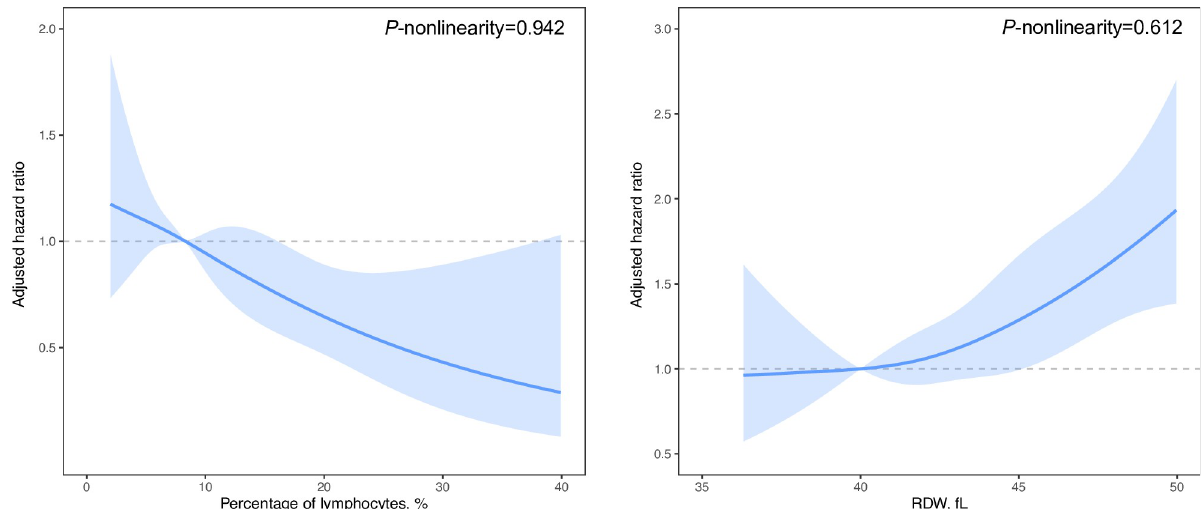
Fig 2. Dose-response curves for lymphocyte percentage and RDW level with risk of AAD in-hospital mortality. Hazard ratios (blue lines) and 95% confidence intervals (light blue shade) were adjusted for age, sex, smoking history, hypertension history, diabetes history, aortic valve replacement history, anatomical classification, etiology, aorta diameter, onset time and hospital centers. AAD, acute aortic dissection; RDW, red blood cell distribution width.